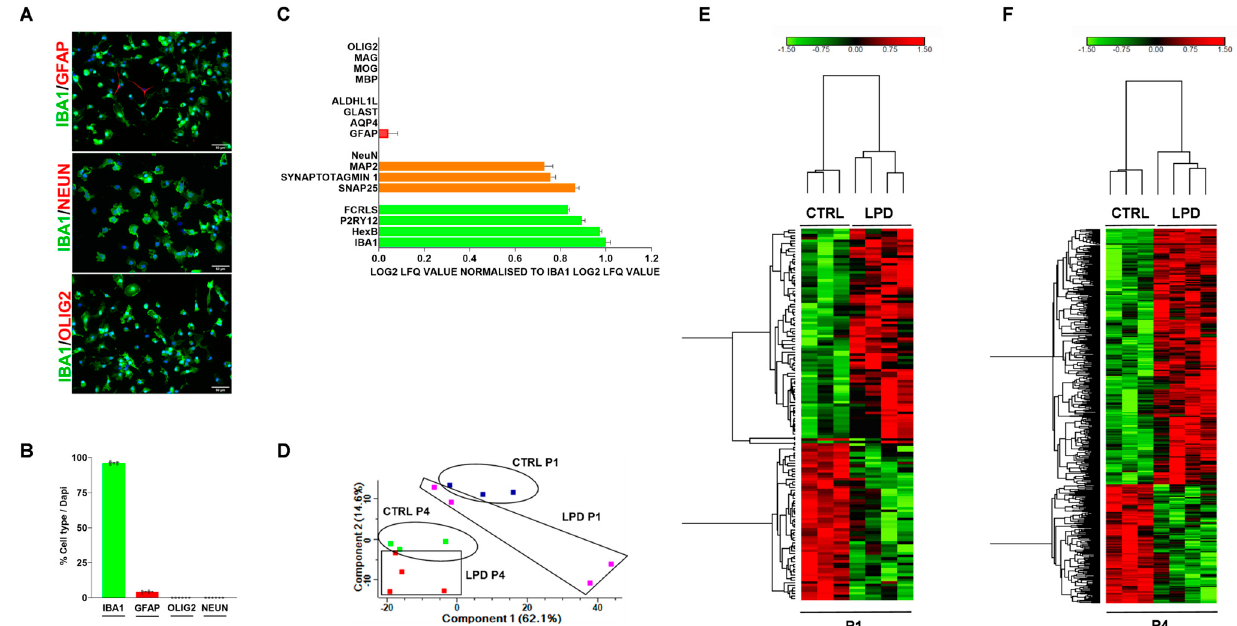
Figure 1. Assessment of cell purity after sorting and sample clustering. Microglial cells were stained with Iba1 (green), either GFAP, Olig2, or NeuN (red), and DAPI (blue). ( A ) Representative photomicrographs at ×20 magnification (scale bar = 50 µm). ( B ) Percentage of IBA1+, GFAP+, Olig2+, and NeuN+ cells normalized to DAPI staining. ( C ) Expression of microglial (FcRLS, P2RY12, HexB, Iba1), neuronal (NeuN, MAP2, Synaptotagmin1, SNAP25), astrocyte (ALDHAL1L, GLAST, AQP4, GFAP), and oligodendrocyte (Olig2, MAG, MOG, MBP) cell markers in the proteome dataset. ( D ) Principal component analysis. ( E , F ) Heat maps showing the clustering in ( E ) CTRL and LPD at P1 and ( F ) CTRL and LPD at P4. Upregulated proteins are depicted in red and downregulated proteins in green.